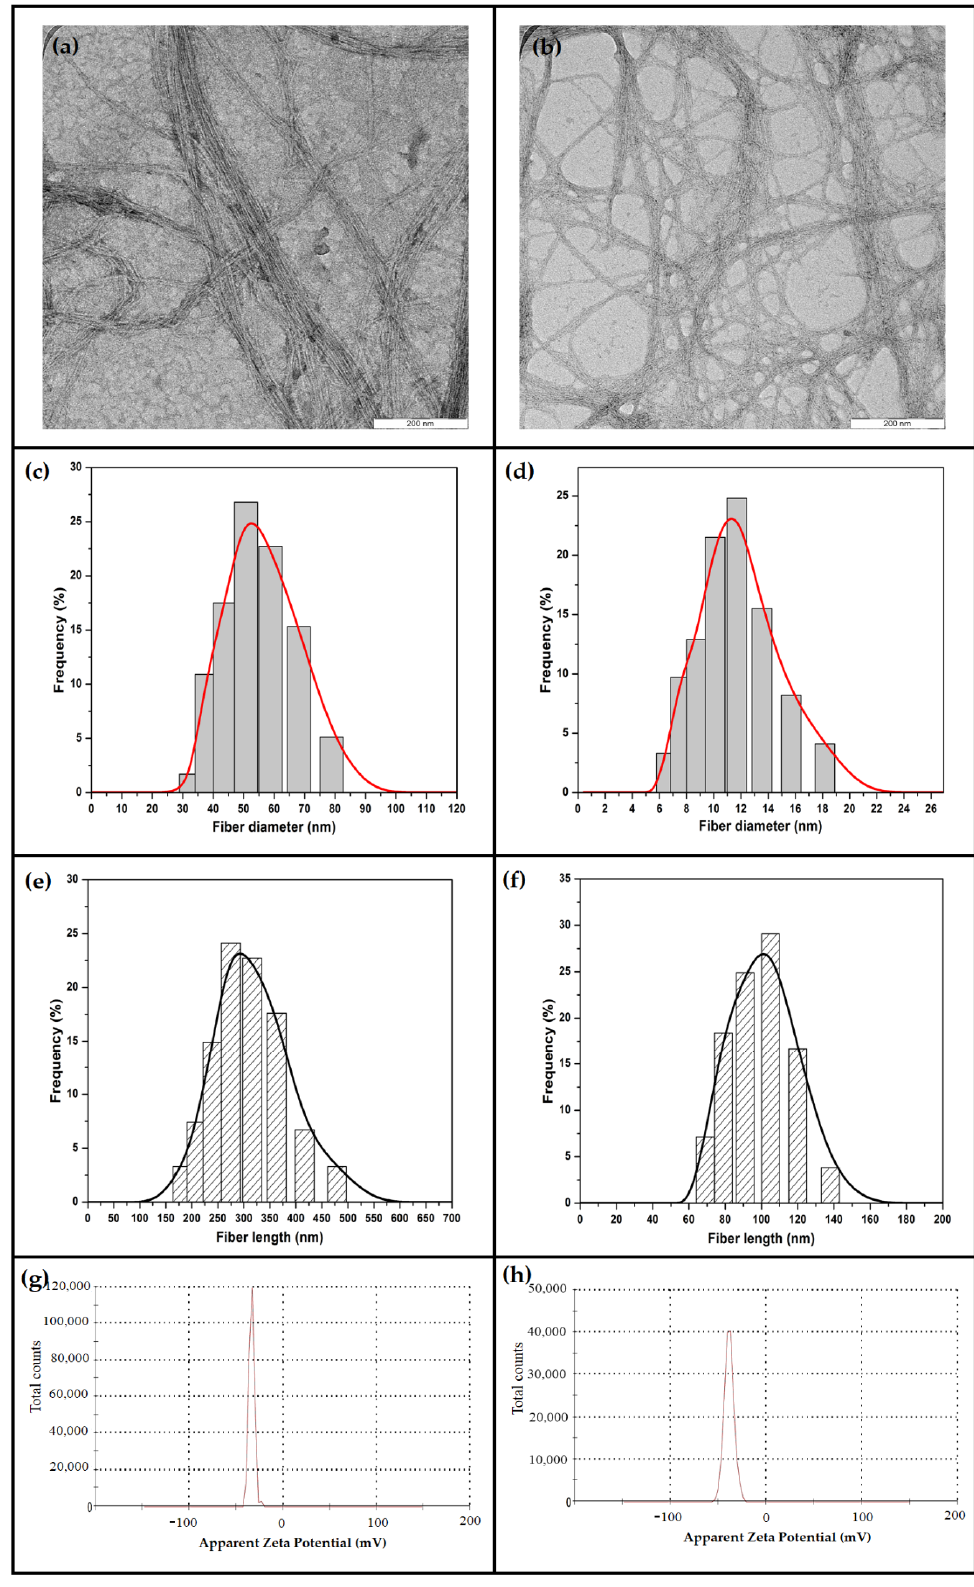
Figure 5. Particle size distribution and Surface charge analysis for non-Sc.CO 2 and Sc.CO 2 obtained CNFs respectively: ( a , b ) TEM micrograph, ( c , d ) fiber diameter, ( e , f ) fiber length, ( g , h ) zeta potential